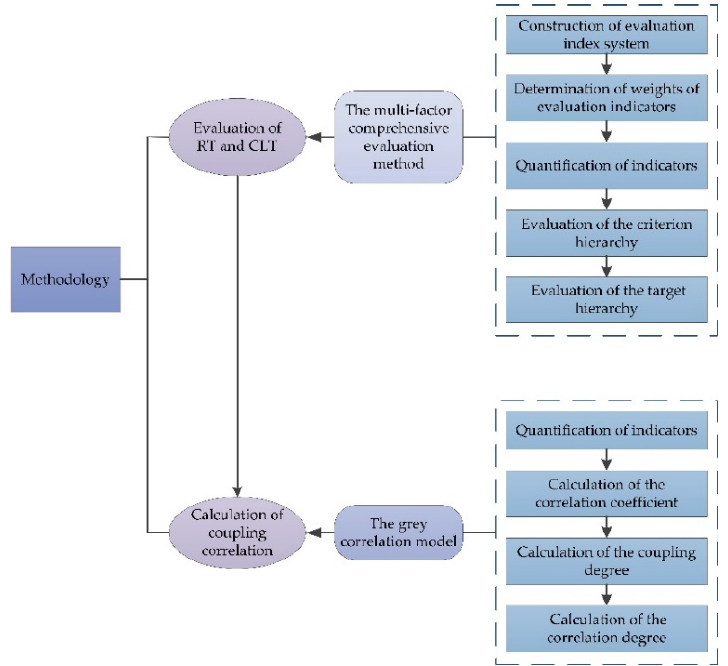
Figure 3. Methodology and